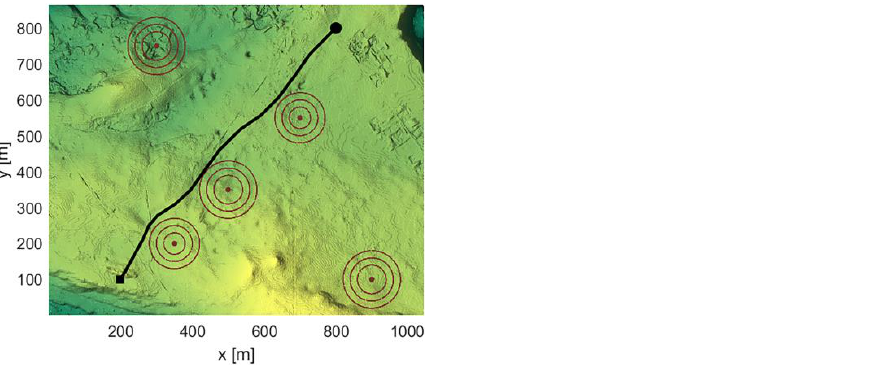
Figure 17. The top view of the paths generated by the IC-VAINDIWPSO algorithm under five threats.